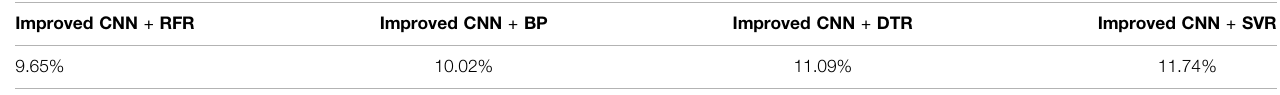
TABLE 2 | The median error of different numerical forecasting methods.